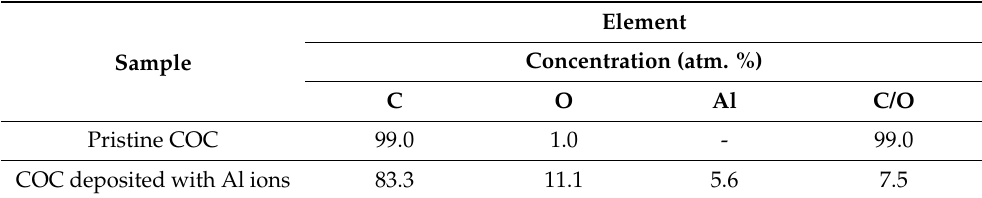
Table 1. Atomic composition of pristine and deposited